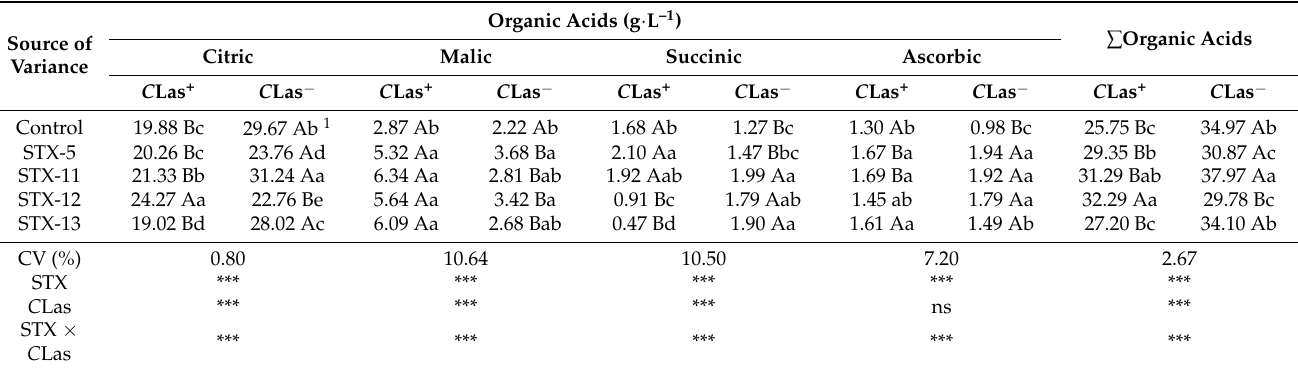
Table 4. Organic acid composition in juice extracted from fruit of ‘ Candidatus Liberibacter asiaticus’ ( C Las + )-inoculated and non-inoculated (CLas − ) STX IA transgenic and non-transgenic control plants of Pera sweet orange ( Citrus × sinensis ).